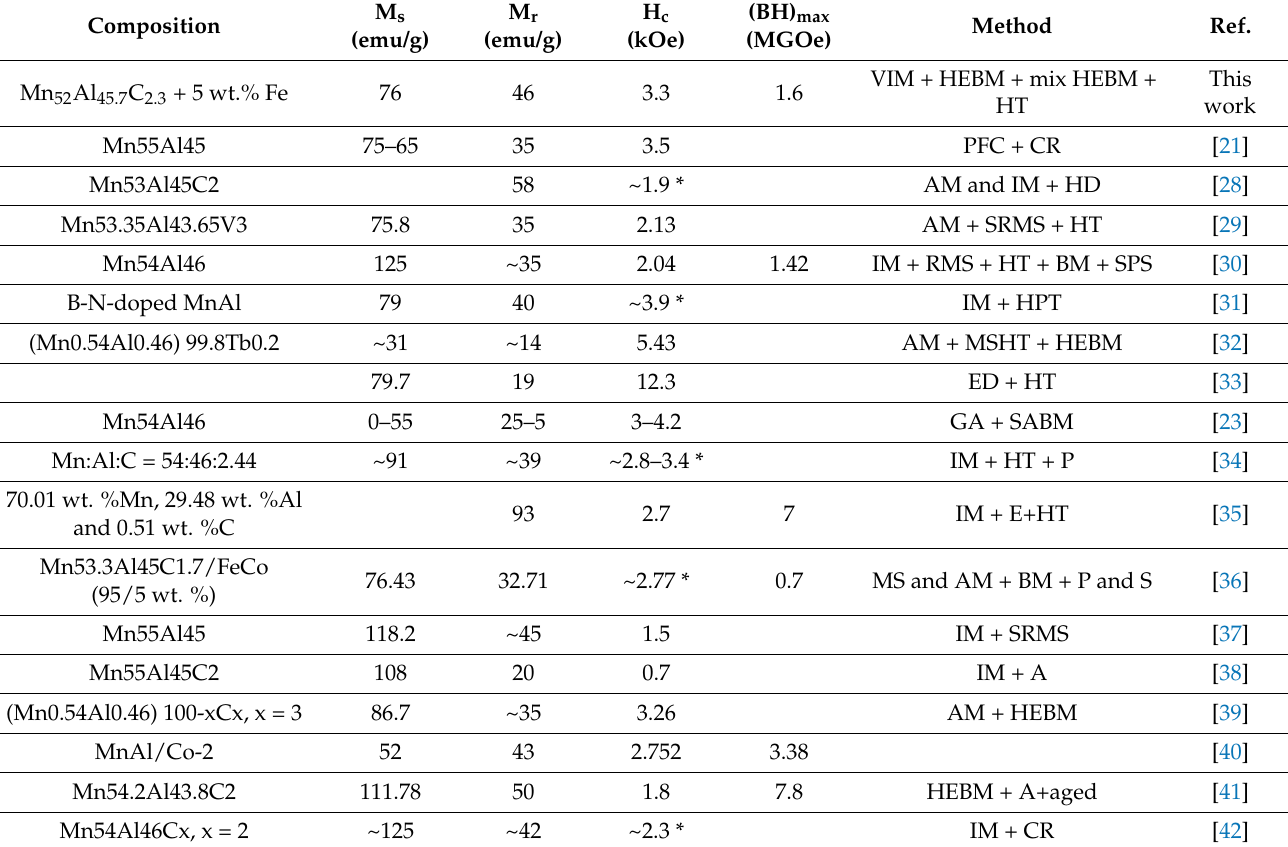
Table 2. Properties reported on the Mn-Al alloy, and comparison with the present